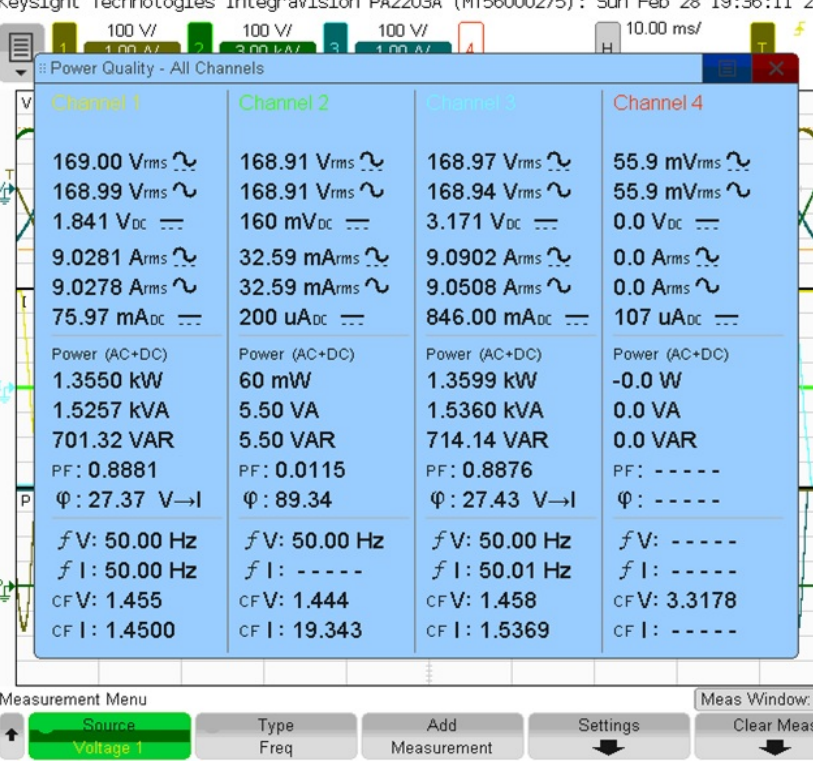
Figure 13. Voltage sag conditions in grid connected to induction motor under loaded conditions.